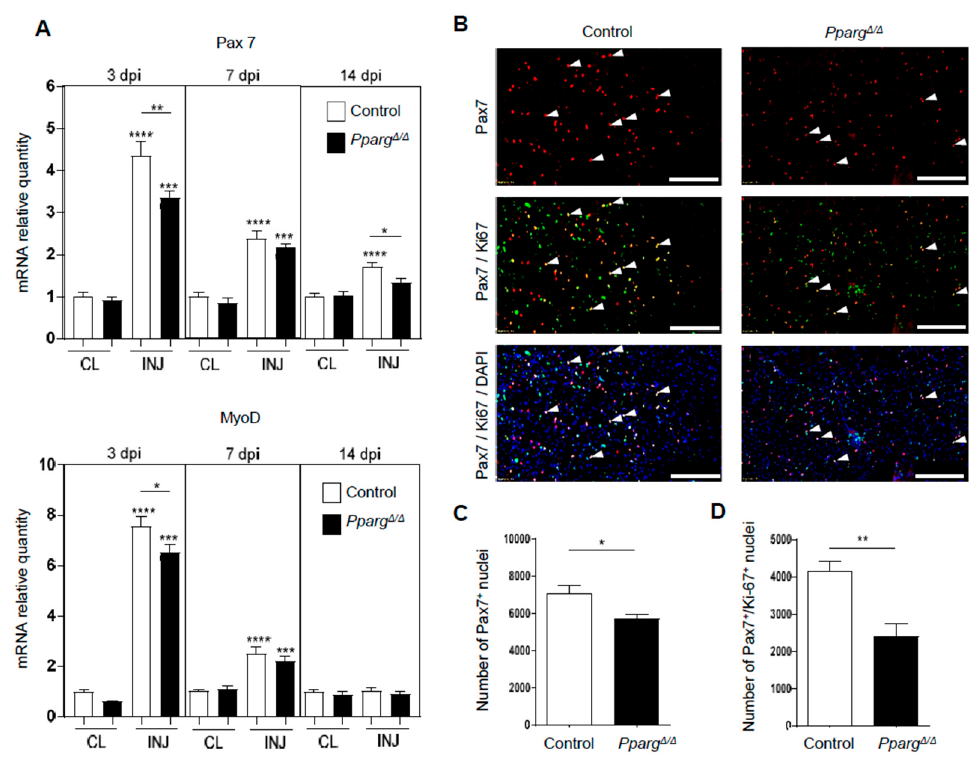
Figure 2. MuSC amplification and commitment are impaired in Pparg ∆ / ∆ mice. Tibialis anterior (TA) muscles from Pparg ∆ / ∆ and control littermates mice were injured with 50% glycerol intramuscular injection and collected at 3, 7, and 14 days post injury (dpi). ( A ) Pax7 and MoyD mRNA quantification by qPCR in injured (INJ) and non-injured contralateral (CL) muscles. Data are normalized to CL muscles of control mice per timepoint, n ≥ 7 mice per group. ( B ) Representative images of TA sections stained for Pax7, Ki-67, and DAPI at 7dpi. White arrows indicate Pax7 + /Ki-67 + nuclei. Scale bar: 200 µ m. ( C , D ) In vivo quantification of total Pax7 + nuclei ( C ) and proliferating Pax7 + /Ki-67 + nuclei ( D ) in injured muscles at 7dpi, with n = 4–5 mice per group. **** p < 0.0001, *** p = 0.001, ** p = 0.01, * p < 0.05 by one-way ANOVA ( A ) or Mann–Whitney test ( C , D ). Unless otherwise indicated, statistical comparisons relate to the CL muscle of control mice.